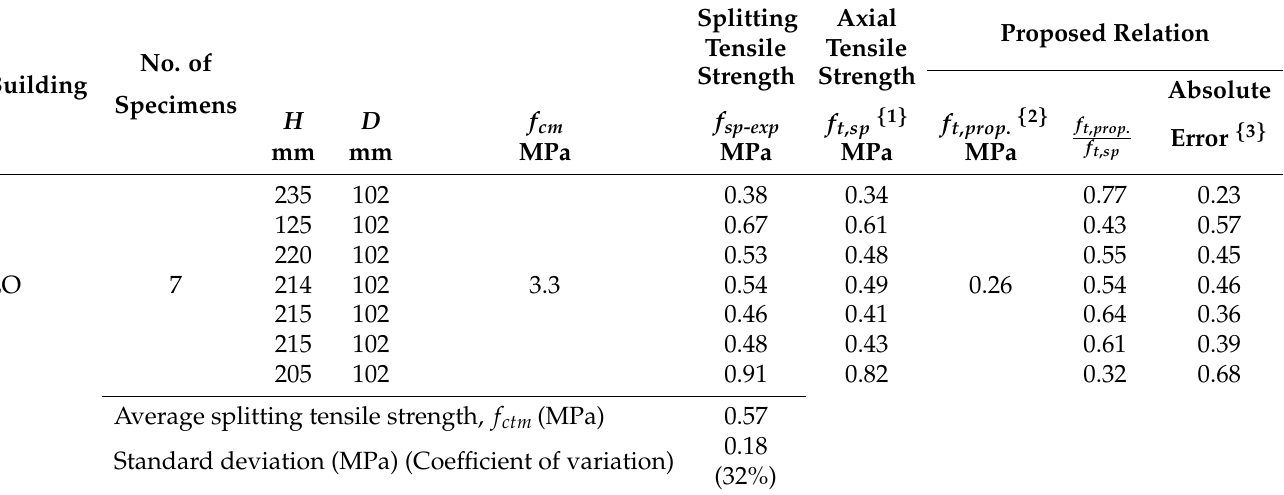
Table 6. Splitting tensile strength of the authentic